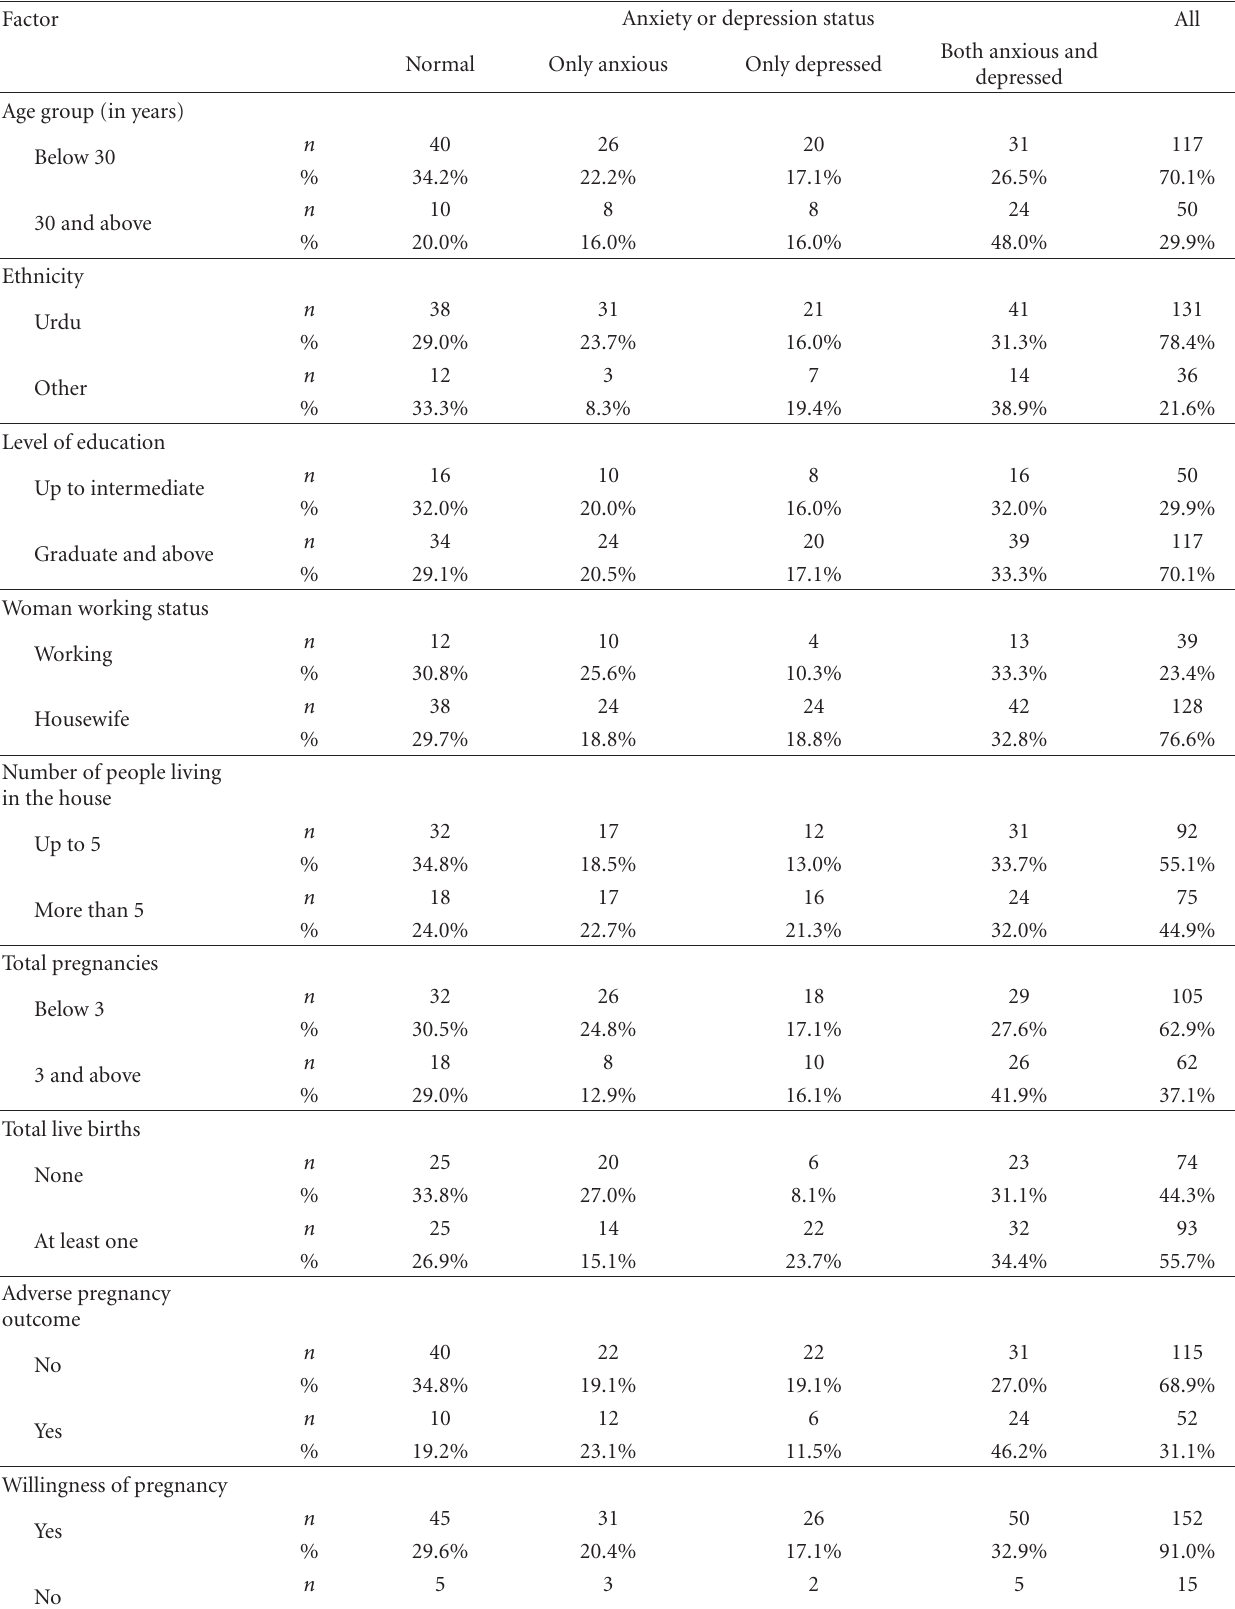
Table 1: Frequency of anxiety and depression by sociodemographic, obstetric, family relationships, and home environment